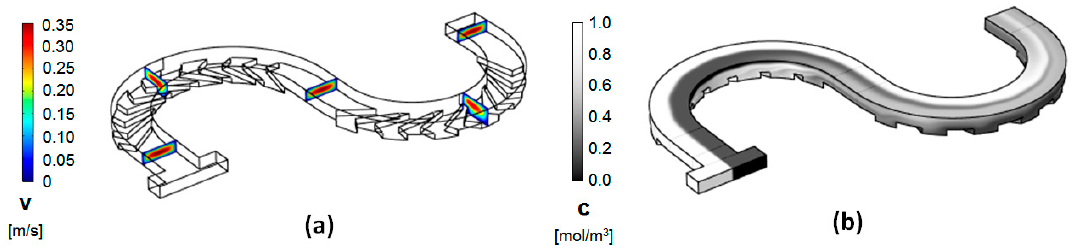
Figure 4. ( a ) Velocity field cross-sections at different positions along the channel; ( b ) Concentration distribution along the channel ( Re = 20; R in = 400 μ m).